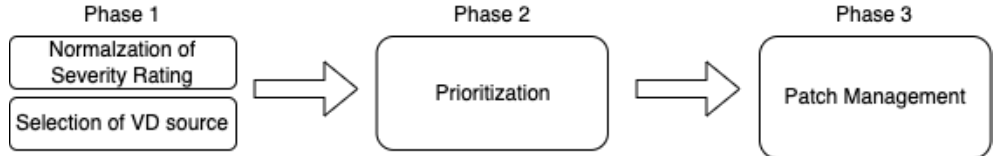
Figure 1. Relationship between our current work (phase 2) and previous work (phase 1), and how they address the ACVRM